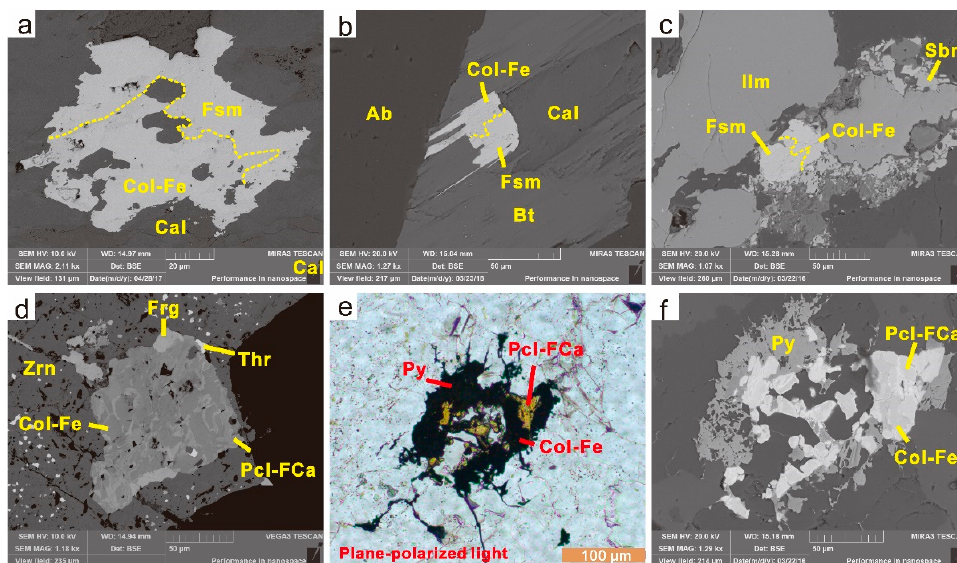
Figure 5. Photomicrographs and back-scattered electron (BSE) images of columbite-(Fe) with associated minerals. ( a – c ) Intergrown particles of columbite-(Fe) and fersmite (BSE); ( d ) Intergrown par- ticles of columbite-(Fe) and fluorcalciopyrochlore (BSE); ( e ) photomicrographs of an incomplete pseudmorph of columbite-(Fe) replaced by fluorcalciopyrochlore; and ( f ) incomplete pseudomorph of columbite replaced by fluorcalciopyrochlore (BSE). Abbreviations: Ab—albite; Bt—biotite; Frg— fergusonite-(Y); Fsm—fersmite; Ilm—ilmenite; Col-Fe—columbite-(Fe); Pcl-FCa—fluorcalciopy-